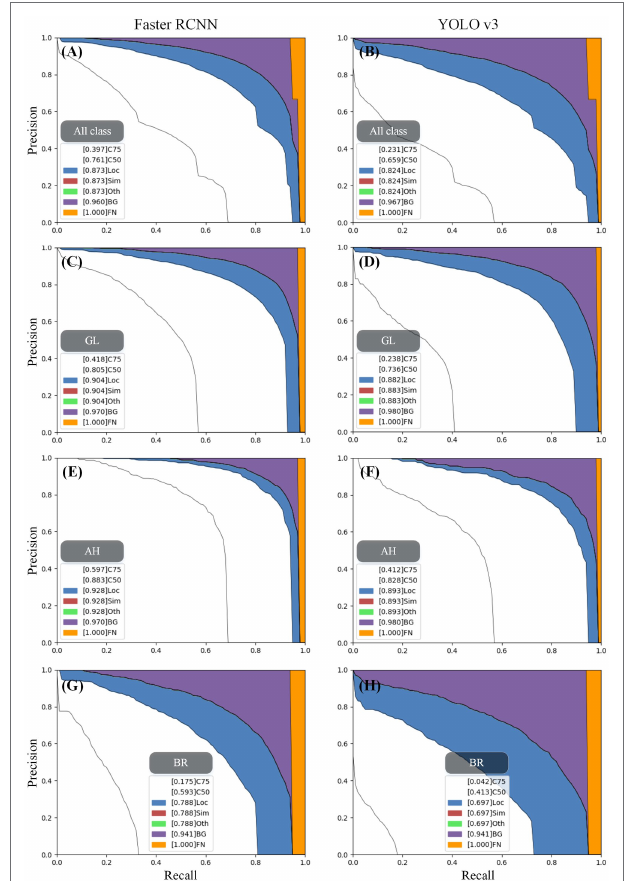
FIGURE 7 | The error analysis of the object detection algorithm for each stress. The analysis of the object detection model includes seven PR curves. Due to the gradual relaxation of evaluation requirements, each curve represents a higher AP as compared to the curve presented on the left. The evaluation requirements of each PR curve are presented as: (1) C75: PR at IoU = 0.75, area under the curve corresponds to AP IoU = 0.75; (2) C50: PR at IoU = 0.50, the white area between C50 and C75 represents the AP gain due to the relaxation of IoU from 0.75 to 0.5; (3) Loc: PR at IoU = 0.10 (localization errors are ignored, but the duplicate detections are not ignored), the larger the blue area between Loc and C50, the lower is the performance of localization; (4) Sim: PR after supercategory false positives (fps) are removed. The larger the red area between Sim and Loc, the higher is the degree of confusion between super categories; (5) Oth: PR after all class confusions are removed. The larger the green area between Oth and Sim, the higher is the degree of confusion between subclasses; (6) BG: PR after all background (and class confusion) fps are removed. The larger the purple area between BG and Oth, the greater is the number of false detections in the background area; (7) FN: PR after all remaining errors are removed (trivially AP = 1). The larger the orange area between FN and BG, the more ground truth boxes are missed. The category labels of subgraphs ( A–H ) can be obtained in each gray